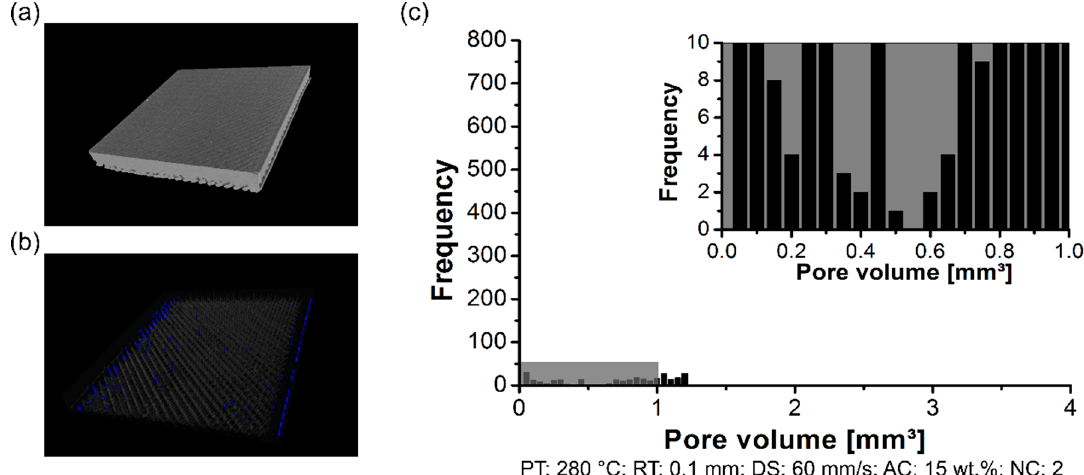
Figure 16. Pore distribution on the 3D ‐ printed ABS for condition seven (PT: 280 °C, RT: 0.1 mm, DS: 60 mm/s, AC: 15 wt.%, and NC: 2): ( a ) scanned volume, ( b ) pores distribution, and ( c ) pore volume histogram.